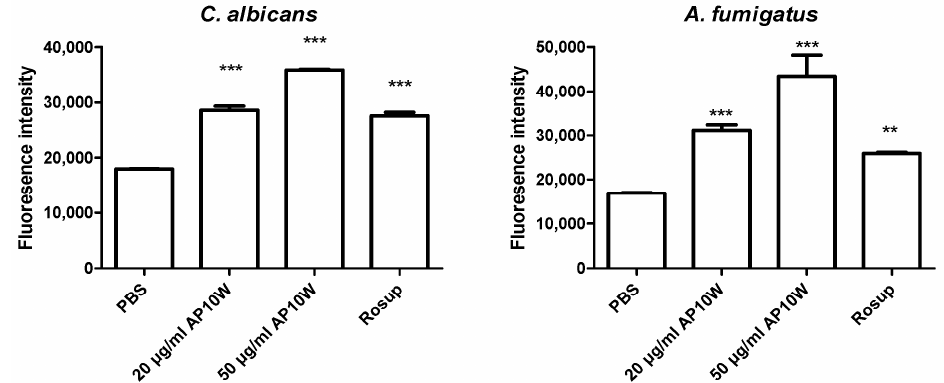
Figure 7. Effects of AP10W on intracellular ROS levels. The fungi C. albicans and A. fumigatus were treated with AP10W. Rosup, a compound mixture, can significantly increase ROS levels in cells within 30 min. PBS was used as control. Data were expressed as means ± SD (n = 3) from three independent experiments. ** p < 0.01, *** p < 0.001.